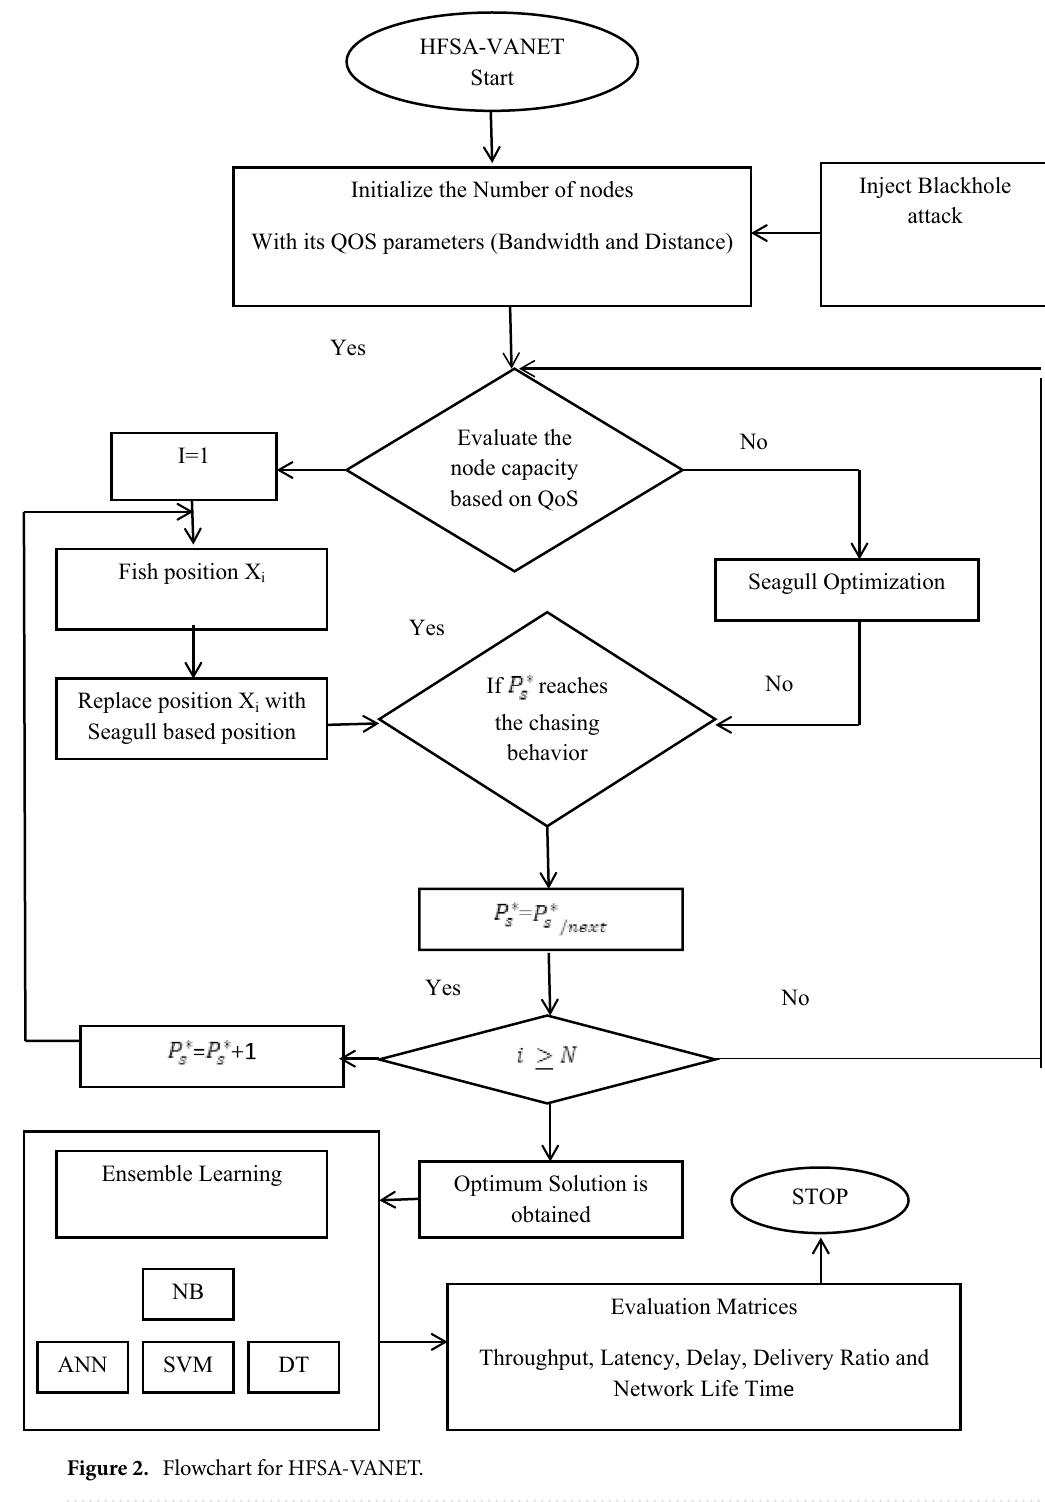
Figure 2. Flowchart for